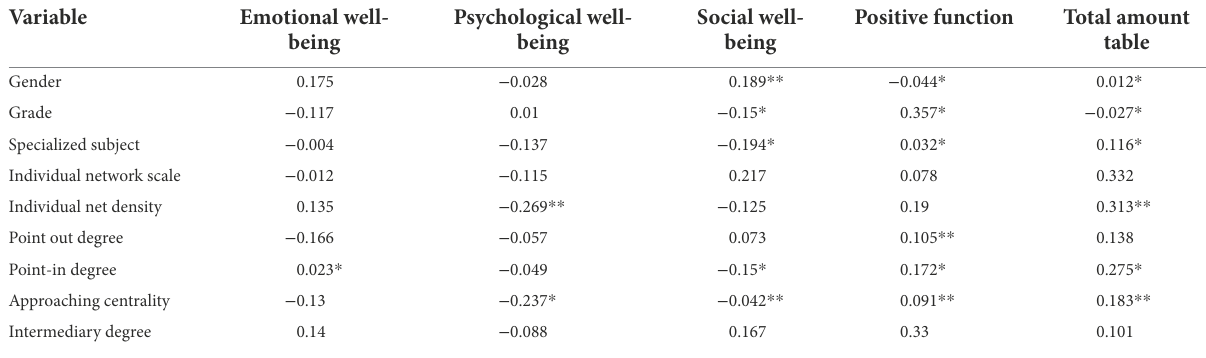
TABLE 4 Correlation coefficient between optimism and mental health variables.